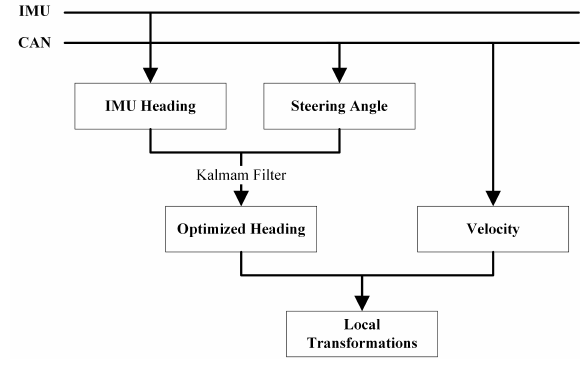
Figure 3. The structure of the fused reckoning